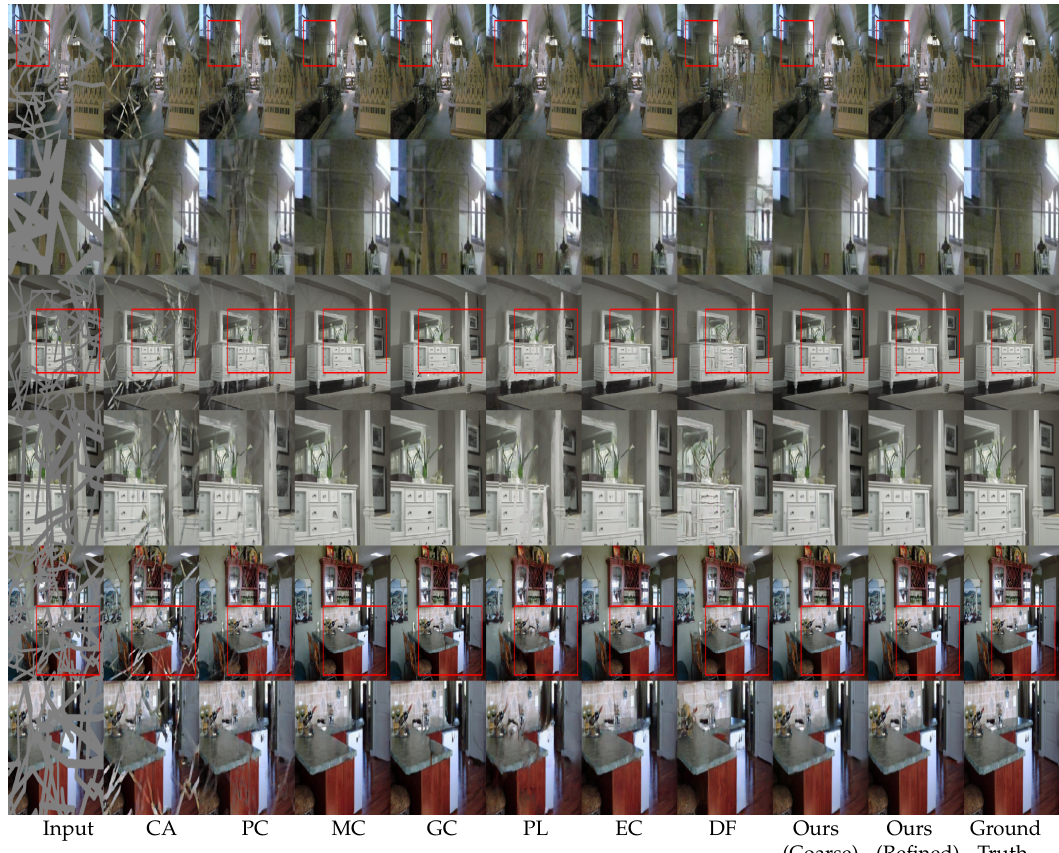
Figure 6. Qualitative comparison of Places365 [21] dataset. From the left: input, CA [14], PC [17], MC [18], GC [16], PL [39], EC [19], DF [40], proposed method (coarse output), proposed method (refined output), and the ground truth. It can be seen from the image that our model generates more consistent structures and textures compared with the state-of-the-art